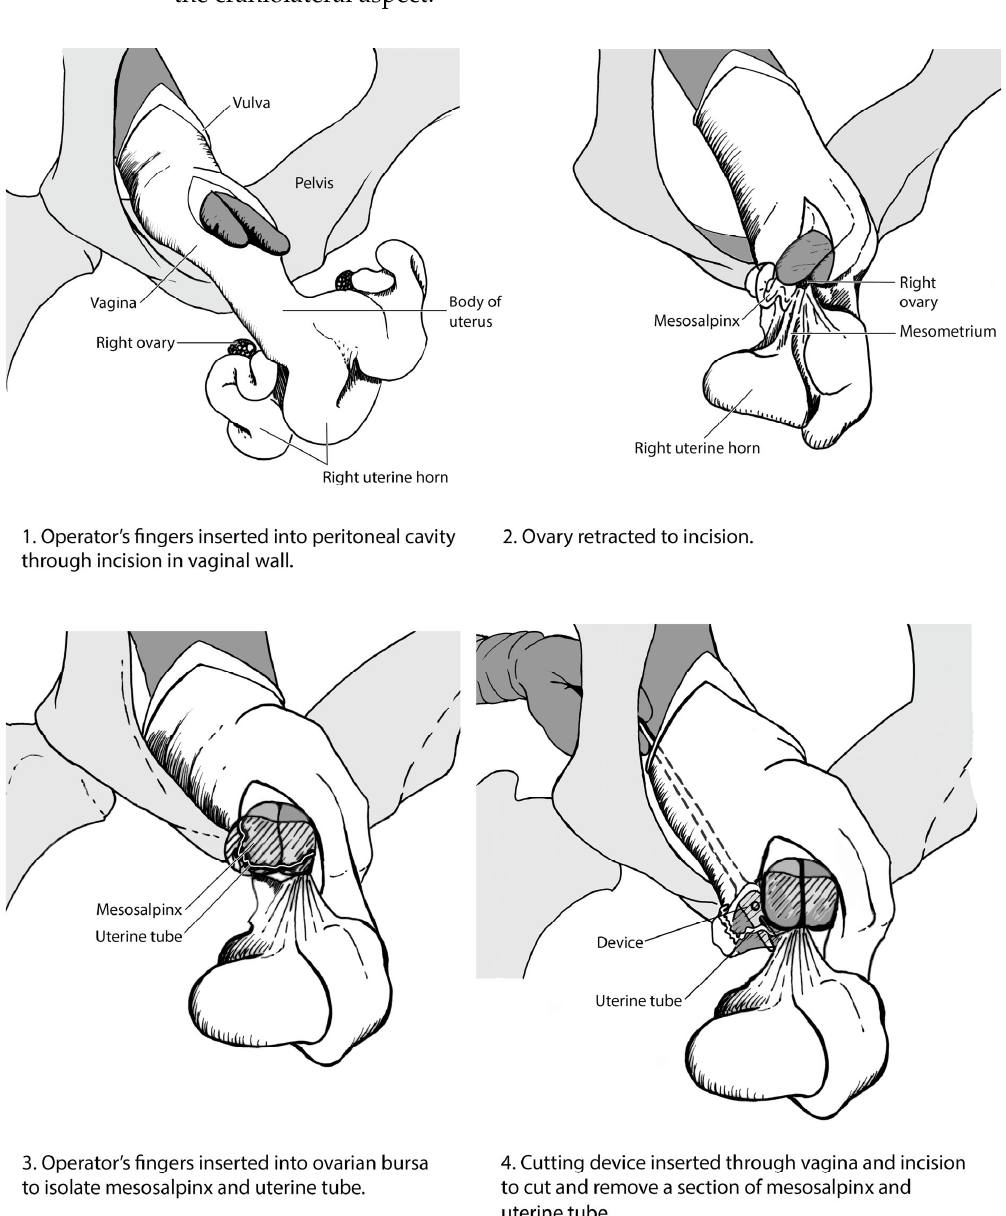
Figure 2. Stages of the uterine tube resection via the vaginal procedure as described in the text. The uterine tube cutting tool (Figure 3) consisted of two inward ‐ facing size 22 scalpel blades mounted in a slot in a protected head assembly, with a shaft approximately 400 mm in length. The blades were spaced close to each other such that they severed tissue pulled into the instrument’s slot. The cutting instrument was passed into the vagina, through the incision, toward the ovary. The ovarian bursa was held under tension and the blades of the cutting tool passed around the fold of bursa containing the uterine tube